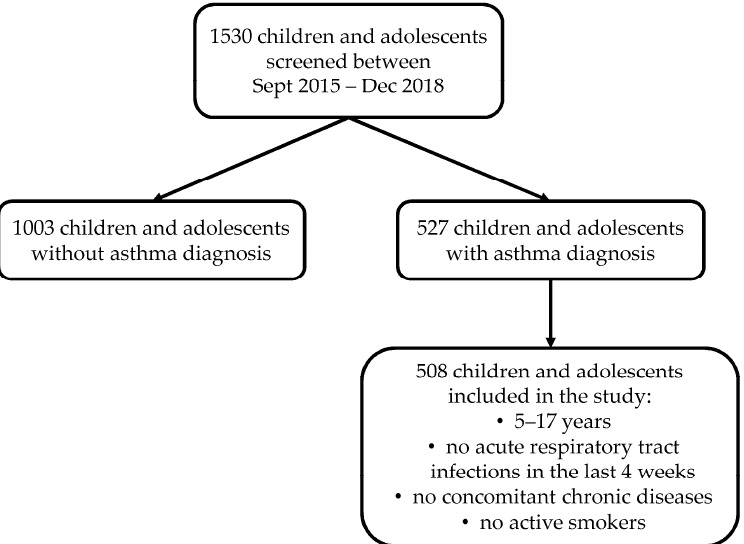
Figure 1. Flowchart describing the recruitment of individuals. The inclusion criteria were: (1) doctor diagnosis of asthma according to the “Global Initiative for Asthma” (GINA) guidelines (www.ginasthma.org, accessed on 13 June 2022); (2) age 5–17 years; (3) ability to perform spirometry. The exclusion criteria were: (1)